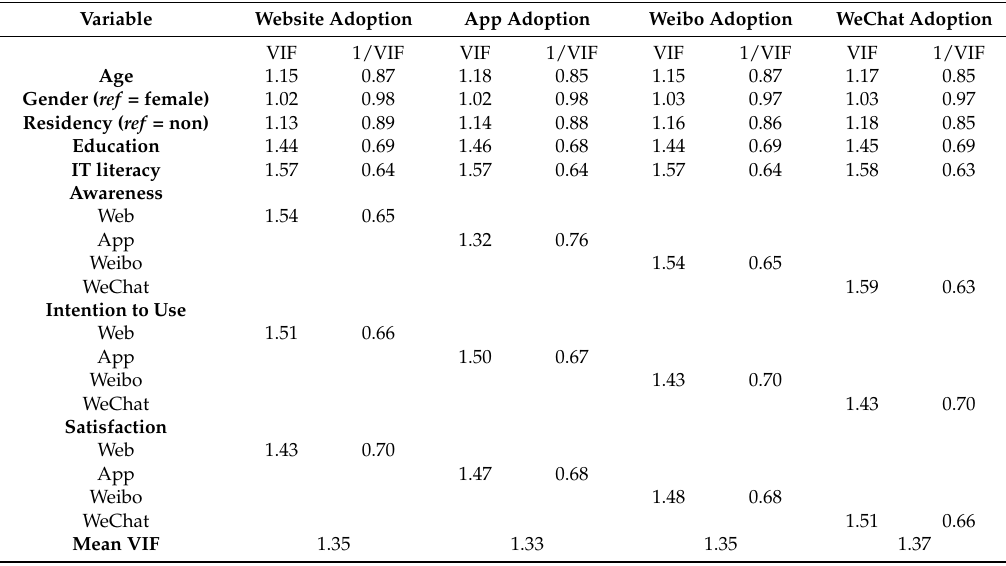
Table 3. Results of Variance Inflation Factor (VIF) of Regression